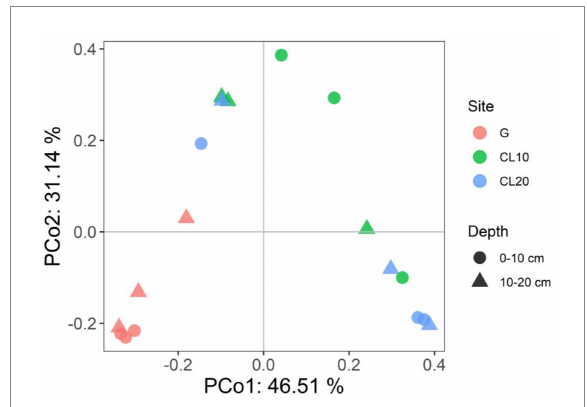
FIGURE 3 Principal co-ordinates analysis (PCoA) of bacterial communities under different land use types and